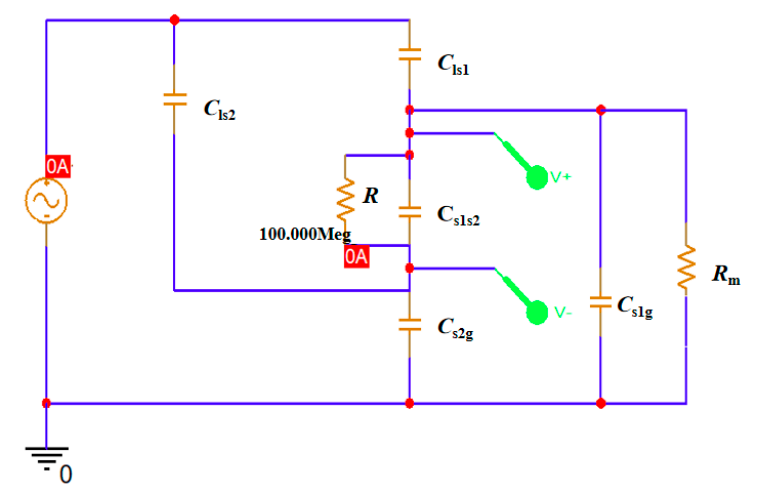
Figure 3. Circuit simulation diagram.